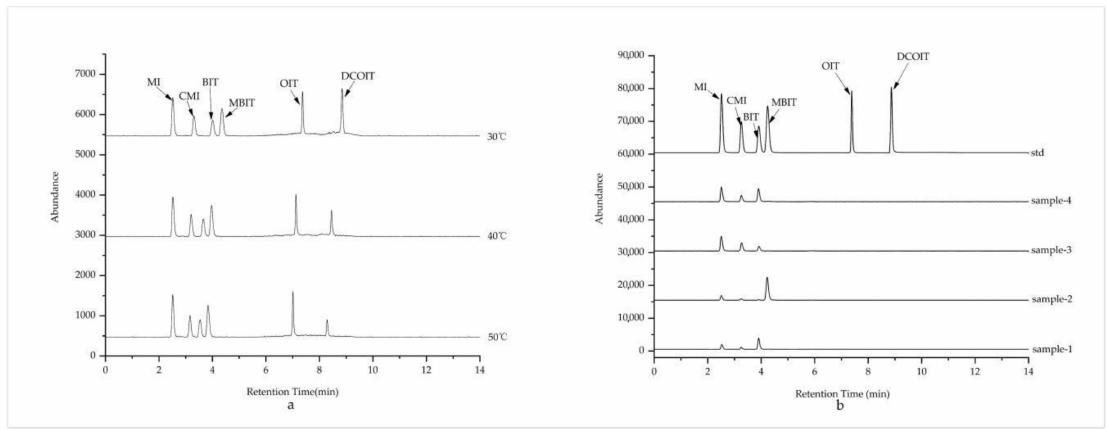
Figure 3. The TIC chromatogram of targeted isothiazolinones: ( a ) The TIC chromatogram of targeted isothiazolinones in standard solution at di ff erent column temperatures, ( b ) The TIC chromatogram of targeted isothiazolinones in standard solution and real water-based adhesives in positive ionization